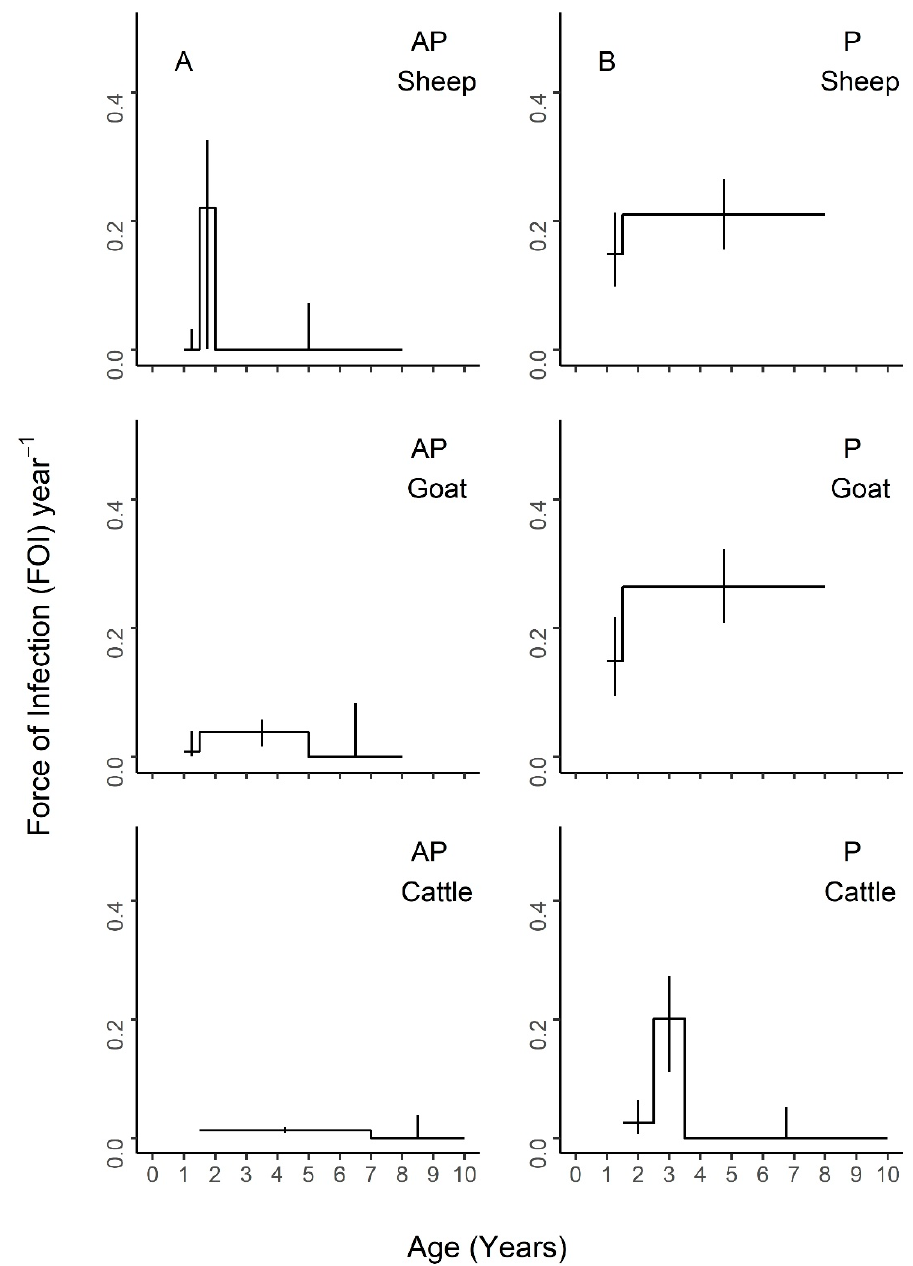
Figure 6. Age-varying force of infection models are a better fit than constant models for PPRV transmission by species and management system. Age-specific force of infection estimates and profile confidence intervals from the best fit models for each species from a piece-wise catalytic model, stratified by management system. ( A ) Agropastoral (AP) ( B ) Pastoral (P)